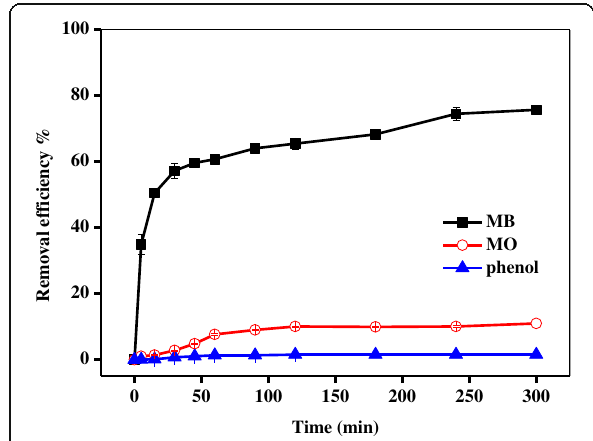
Fig. 3 The removal efficiency of MB, MO and phone adsorbed by Fe 3 O 4 /PCC MNPs. As shown as Fig. 3, the blank line represent the removal efficiency of MB, the red line reperesent the removal of MO, and the blue line represent the removal of